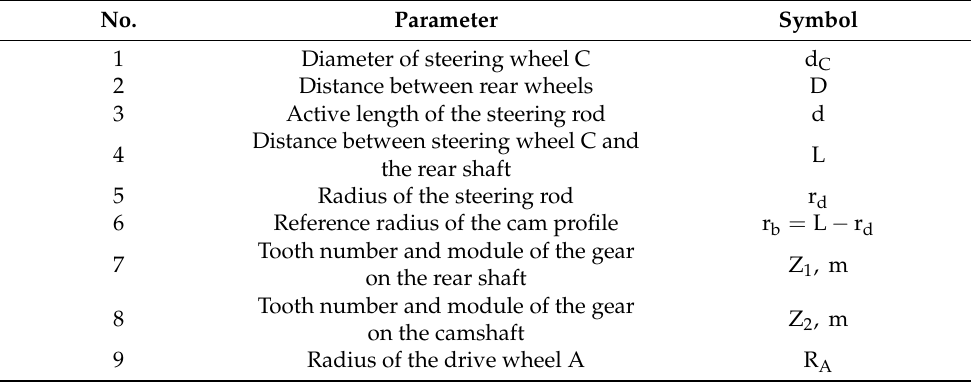
Figure 1. Sketch of the cam-controlled traction tracking structure. Table 1. Device parameters (moving straight